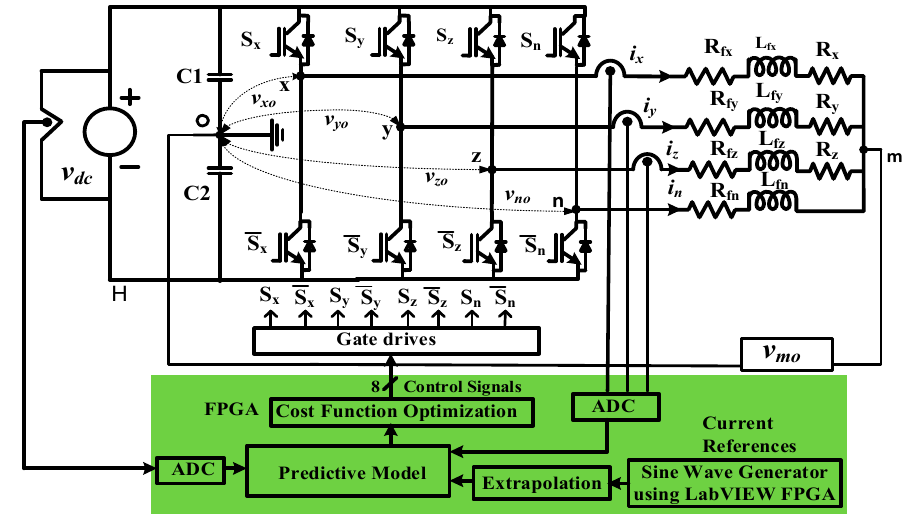
Figure 1. Three-phase four-leg inverter with a field programmable gate array (FPGA) control block.